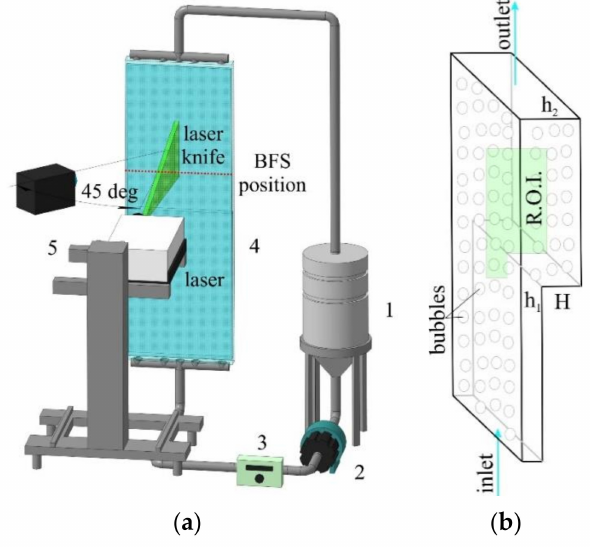
Figure 1. The scheme of the experimental setup ( a ): 1 is the water tank, 2 is the pump, 3 is the flowmeter, 4 is the test section, 5 is the PIV/PLIF system. ( b ) The scheme of a two-phase bubbly upward flow behind a backward-facing